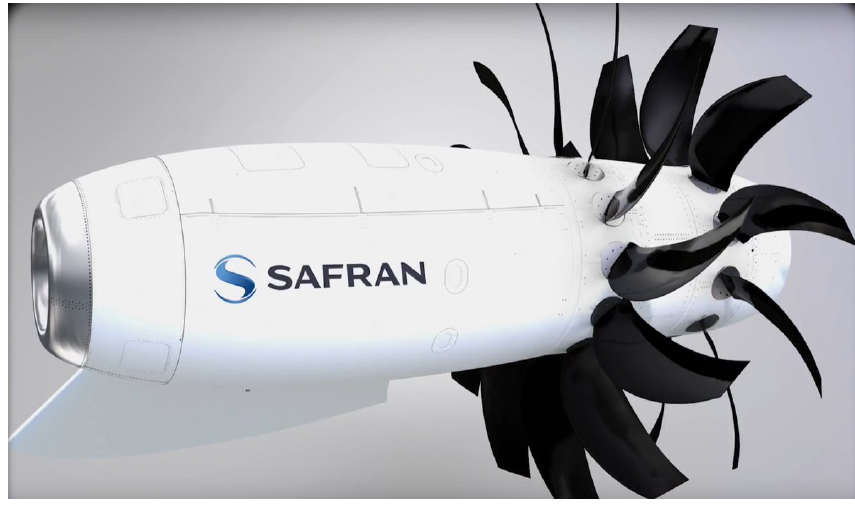
Figure 11. Open Rotor prototype by